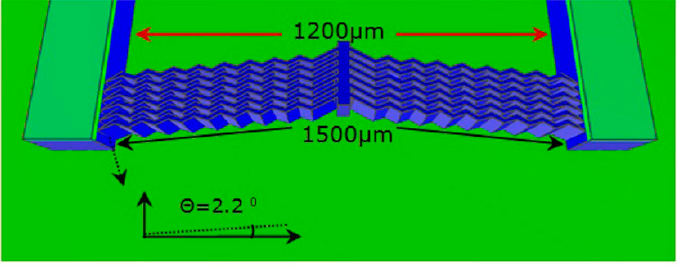
Figure 3. Six spring chevron beams measuring 1500 μm in length with a cross -sectional area of 10 μm × 100 μm and a rib angle of 2.2°.